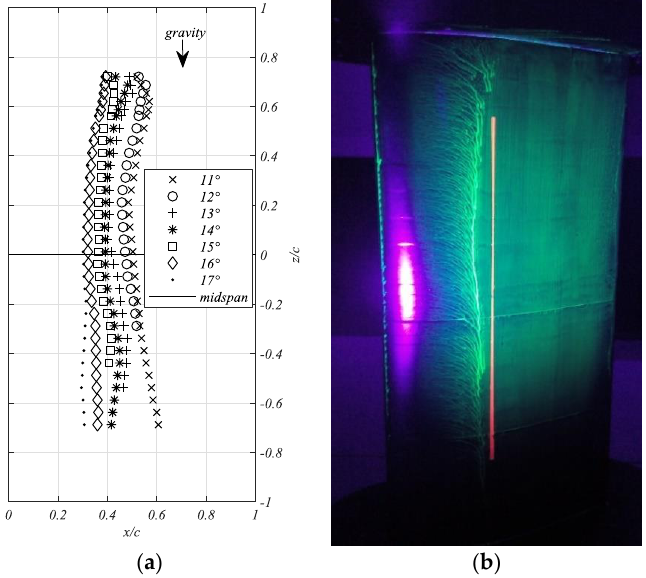
Figure 7. Flow separation line based on oil flow visualization. ( a ) Angle of attack from 11 ◦ to 17 ◦ , ( b ) angle of attack α = 16 ◦ . Re = 0.5 × 10 6